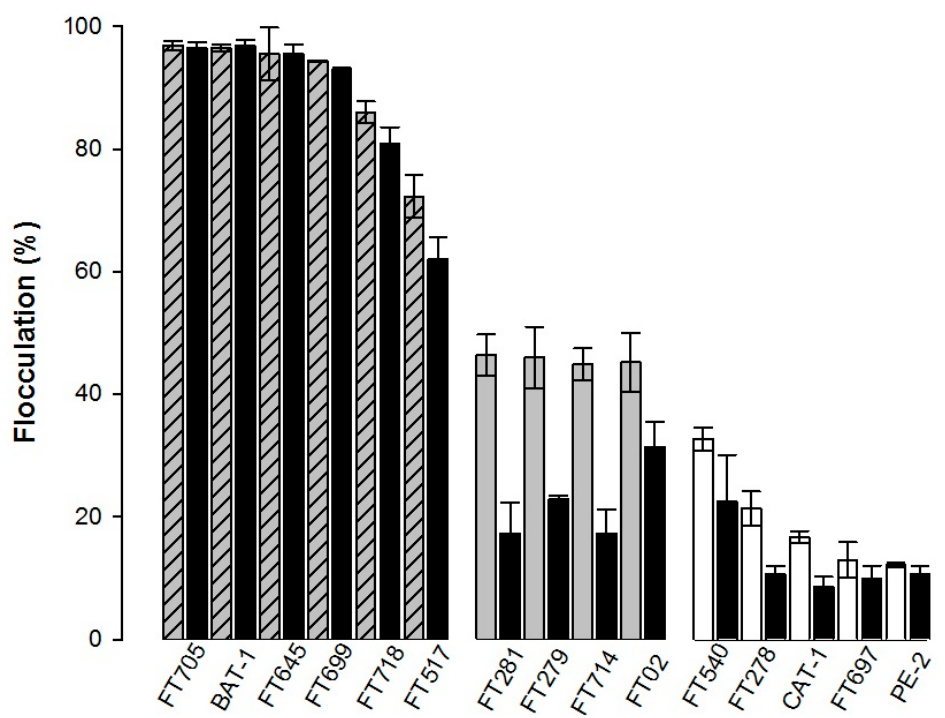
Figure 3. Cellular flocculation by the analyzed industrial fuel-ethanol yeast strains. Flocculation was determined as the percentage of sedimented cells after 10 min in rest, in the absence (black bars) or presence (white, grey, and striped grey bars) of 20 mM Ca 2+ .